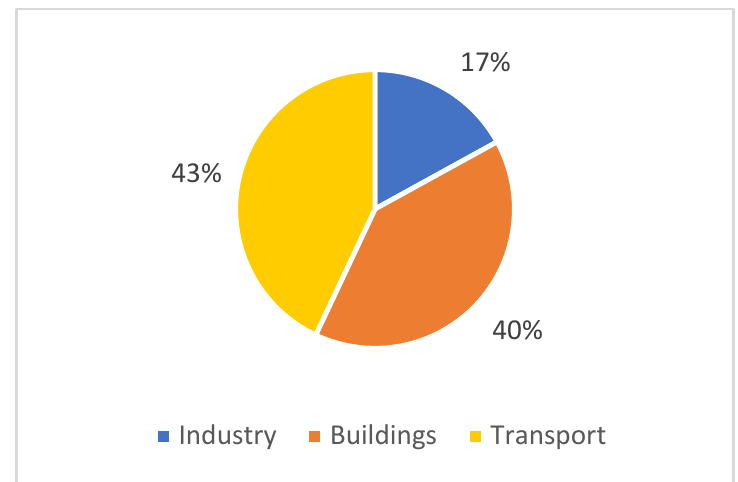
Figure 1. Distribution of primary energy consumption in the world. In 1995, W. Gilijamse [4] highlighted the difference between electrical consumption and electrical production by introducing the connection between renewable energy systems and electrical national